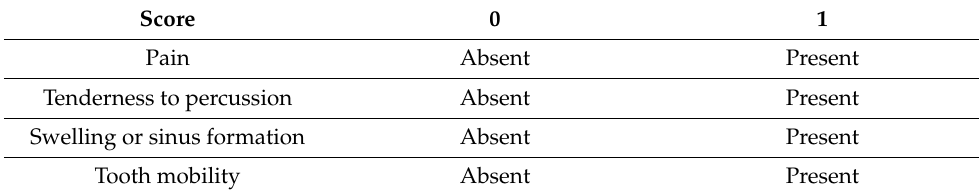
Table 2. Scoring criteria for the parameters for clinical evaluation of pulpotomised molars.